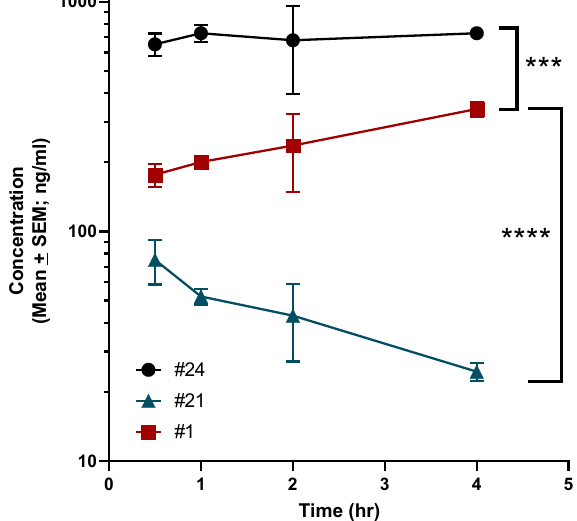
Figure 3. Pharmacokinetic evaluation of compounds 1 , 21 and 24 in mice. Mice were administered 3 mg/kg of each compound by IP injection as has been described in the Methods. The concentration of each compound in the brain was calculated using LC-MS at various time points. Data are presented as mean ± standard error. Statistical significance was determined using ANOVA with Dunnett’s multiple comparisons test. Significance indicated as **** p < 0.00001; *** p < 0.0001.